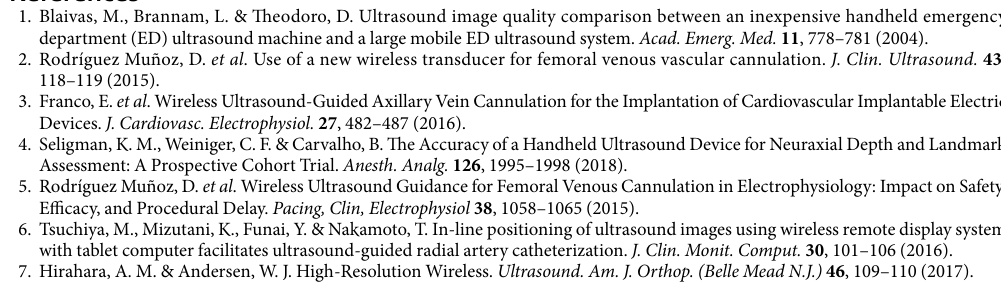
of the third finger were examined with the patient in a seated position. Scanning of the supraspinatus tendon took place when the patient had the palm of the hands on the iliac crest and the elbow directed posteriorly; the maximum thickness of the supraspinatus tendon was measured scanning it in a long-axis view to 1.5 cm from the greater tuberosity of the humerus. Instead, median nerve and flexor tendon of the third finger were scanned with the arms extended on the couch with the palm of the hands upward. The cross sectional area of the median nerve was measured in an axial view, at the proximal inlet of the carpal tunnel at the level at which it was possible to recognize the most palmar point of the pisiform bone, using the direct tracing method with an electronic caliper; the thickness of the flexor tendon was assessed, in a longitudinal view, at the level of the mid part of the proximal phalanx of the third finger. During patellar tendon examination, the patient was in a recumbent position with the knees slightly bent, whereas the Achilles tendon was scanned with the patient laying prone and the gastrocnemius muscle relaxed. In the patellar and Achilles tendons the thickness was measured in three points (proximal, mid an distal part) in a longitudinal view. Regarding the patellar tendon, the proximal and distal parts corresponded to the bottom pole of the patella and to the insertion of tibial tuberosity, respectively, while the mid part corresponded to the exact half of the same tendon. Instead, the proximal part of the Achilles tendon corresponded to a point 5 cm away from the calcaneus, the mid part to a point located in the exact half from the proximal and distal parts and the distal part to the point of tendon’s insertion of the calcaneus. The mean value of all measurements from the right and left side was used for statistical evaluation. The time spent for each sonographic assessment was also taken to evaluate the feasibility.